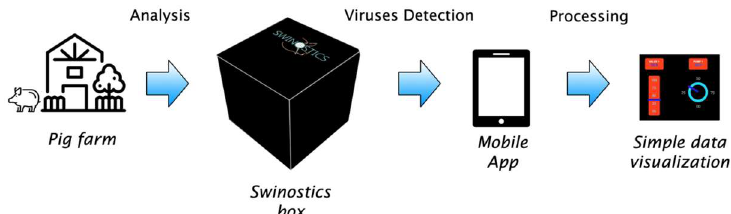
Figure 6. Field application of the SWINOSTICS device. The device will work on the field (Pig farm, veterinary, etc.) and the data will be transferred trough the mobile app to the cloud system.